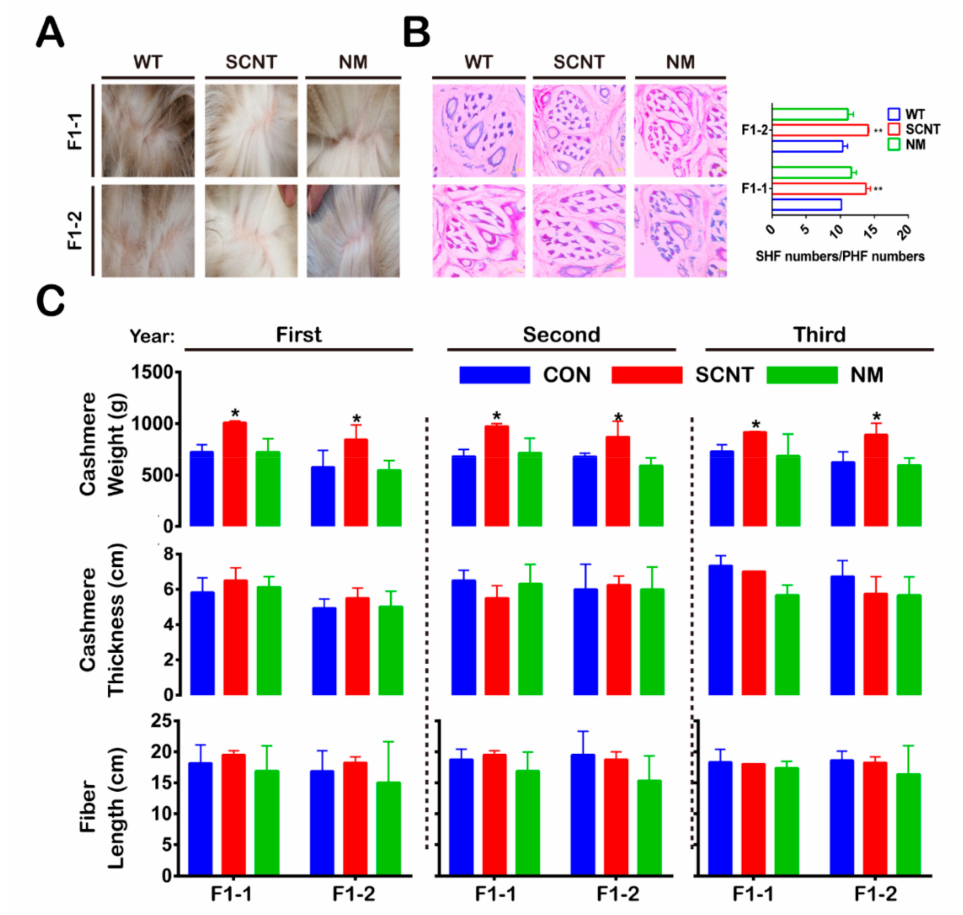
Figure 3. Comparison of the number of hair follicles and cashmere indicators of T β 4-OE first filial generation. ( A ) Comparison of the cashmere growth in di ff erent o ff spring produced by SCNT and NM; SCNT, somatic cell nuclear transfer; NM, natural mating; WT, wild type. ( B ) Hematoxylin-eosin